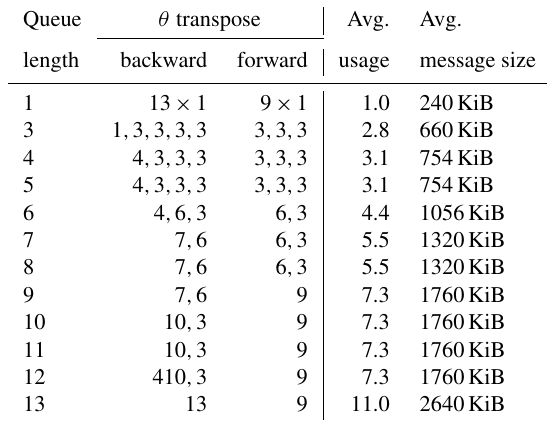
Table 1. Effective usage of θ -transposition buffers (for a single ra- dial point and time step) for the A2AW algorithm. Each number represents how many scalar fields were packed in an individual call to mpi_alltoallw for a single time step and radial point. The average message size was computed assuming 240KiB per scalar field in each rank. Queue θ transpose Avg. Avg. length backward